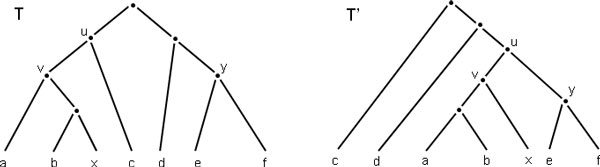
An TBR operation. Tree T' = TBRT(v, x, y) results from T after performing single TBR operation.